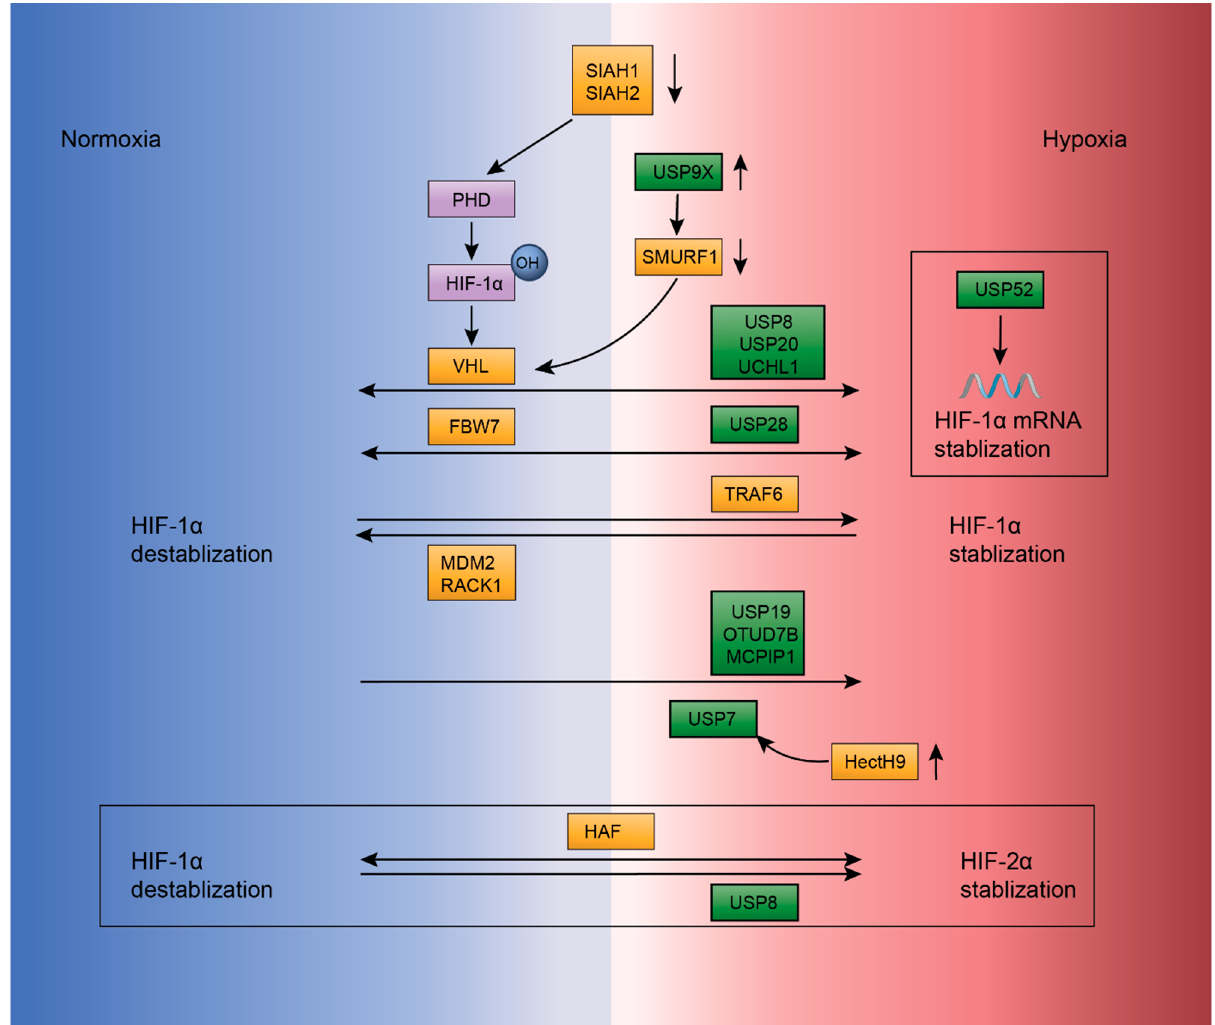
Figure 5. E3s and DUBs involved in modulating the abundance of hypoxia-inducible transcription factor (HIF). HIF (violet rectangles) is the key regulator of the hypoxic response in cells and is composed of the well-characterized HIF-1 α and HIF-2 α subunits. von Hippel-Lindau (VHL) regulates the ubiquitination-mediated degradation of HIF-1 α , which requires hydroxylation of HIF-1 α by prolyl hydroxylase (PHD) (violet rectangles) to occur. Two other E3s (yellow rectangles), SIAH1 and SIAH2, are implicated in the downregulation of PHD. VHL is downregulated by an E3 ligase SMURF1 that is stabilized by a DUB (green rectangles) USP9X. USP8, USP20 and UCHL1 counteract the VHL-mediated ubiquitination of HIF-1 α . FBW7 ubiquitinates HIF-1 α , which is antagonized by USP28. TRAF6, MDM2 and RACK1 are also involved in regulating HIF-1 α . USP7, USP19, OTUD7B and MCPIP1 stabilize HIF-1 α , and HectH9 is required for USP7 activity. HAF and USP8 mediate HIF-1 α and HIF-2 α stabilization. USP52 regulates the stabilization of HIF-1 α mRNA.